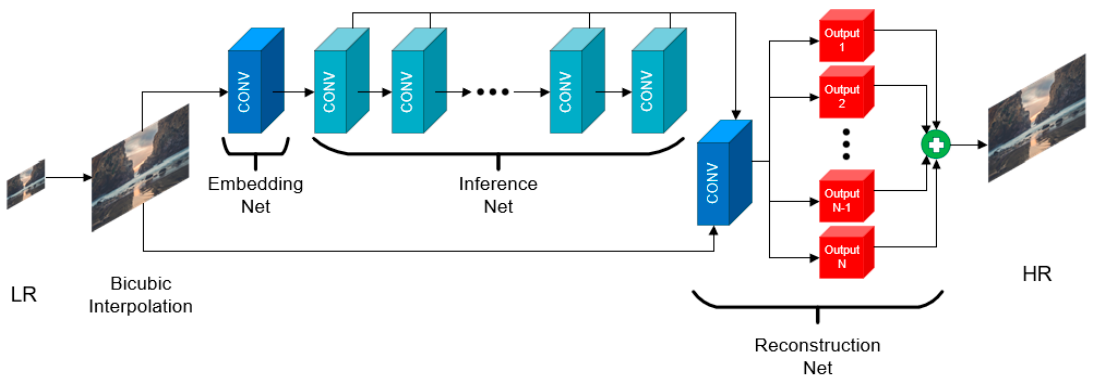
Figure 10. DRCN network structure.